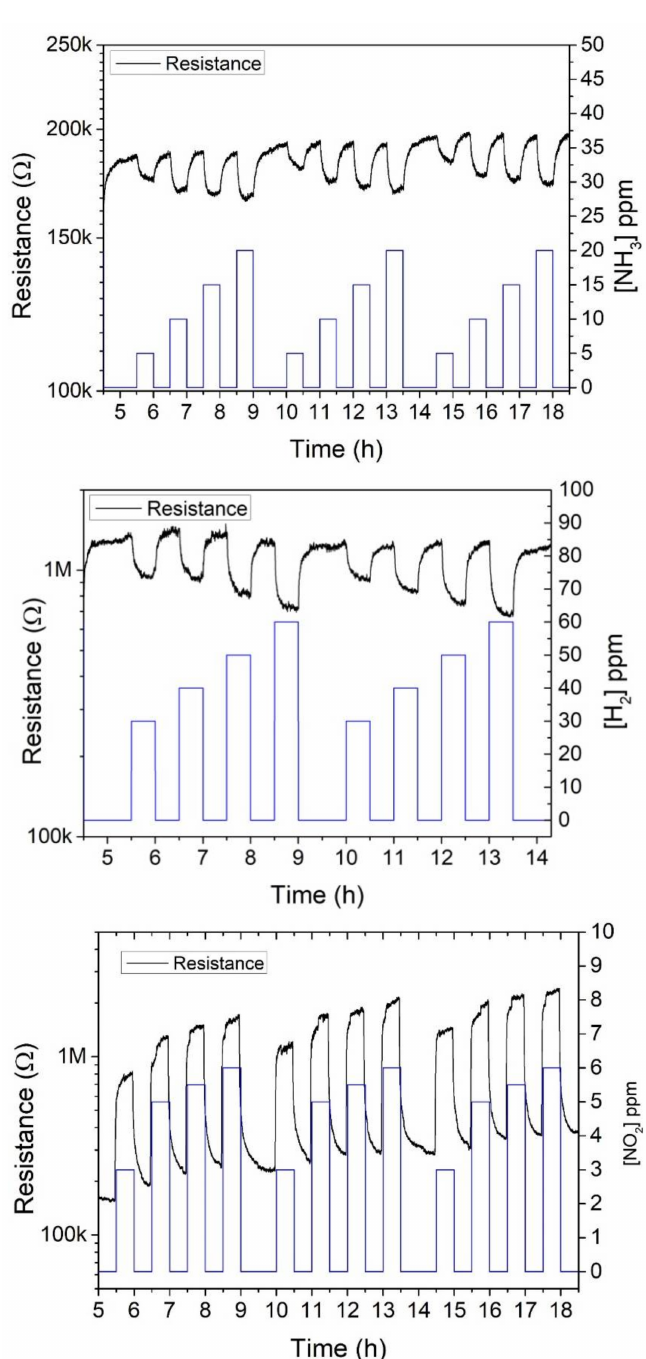
Figure 4. Dynamic evolution of sensor resistance for successive response and recovery pulses of the different species tested. The upper panel corresponds to NH 3 pulses for a sensor operated at 150 ◦ C. The middle panel corresponds to H 2 pulses for a sensor operated at 250 ◦ C. The lower panel corresponds to NO 2 pulses for a sensor operated at 150 ◦